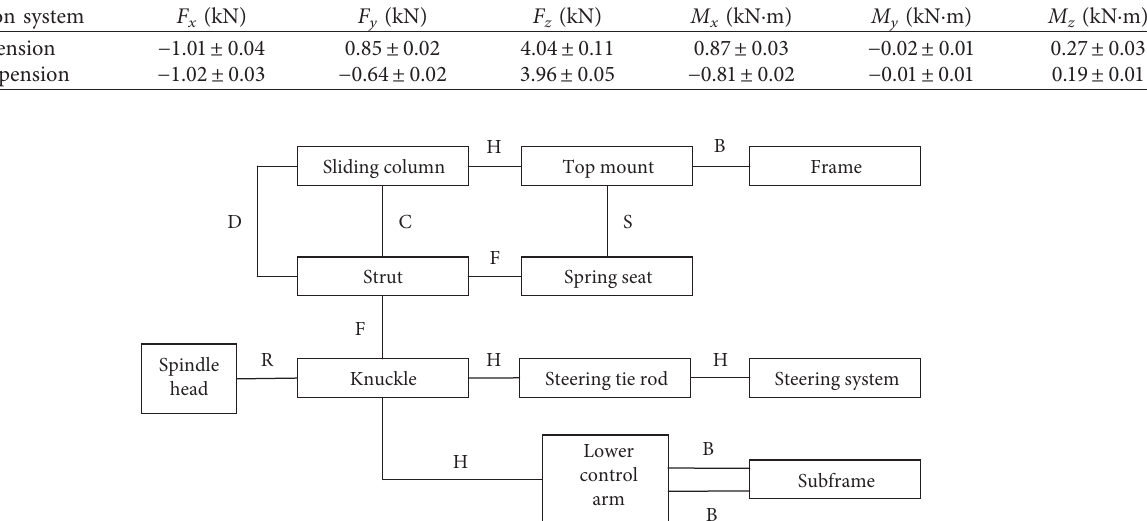
Table 1: Values of six-dimensional wheel force during steer braking under condition of squeal occurrence.